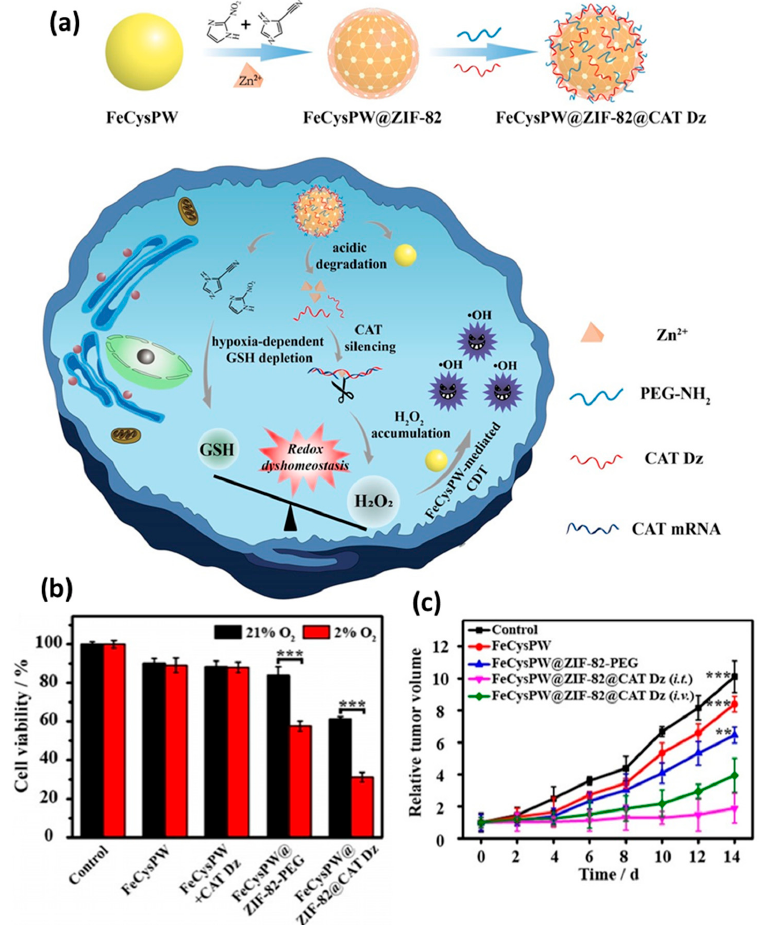
Figure 12. ( a ) Schematic illustration for the synthesis and mechanism of tumor killing of FeCysPW@ZIF–82@CAT Dz. ( b , c ) Tumor killing effect of the FeCysPW@ZIF–82@CAT Dz both in vitro and in vivo. Statistical analysis was based on Student’s t test: ** p < 0.01, *** p < 0.001. Repro- duced from Ref. [143] with permission from Wiley–VCH, copyright